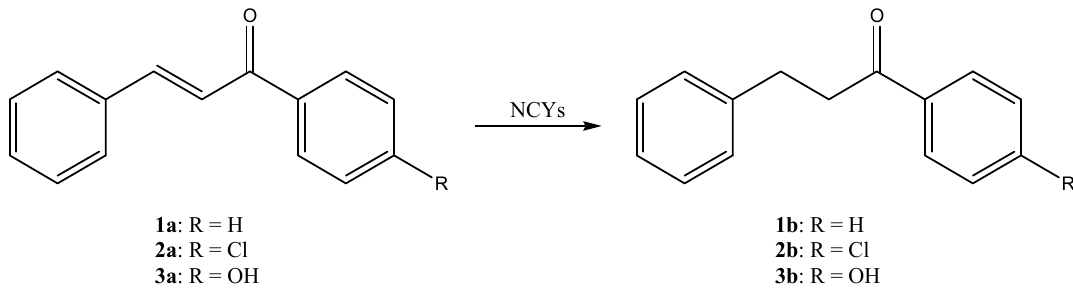
Figure 2. Reaction scheme of the bioreduction of chalcones 1a , 2a and 3a into dihydrochalcones 1b , 2b and 3b , respectively, by NCYs.